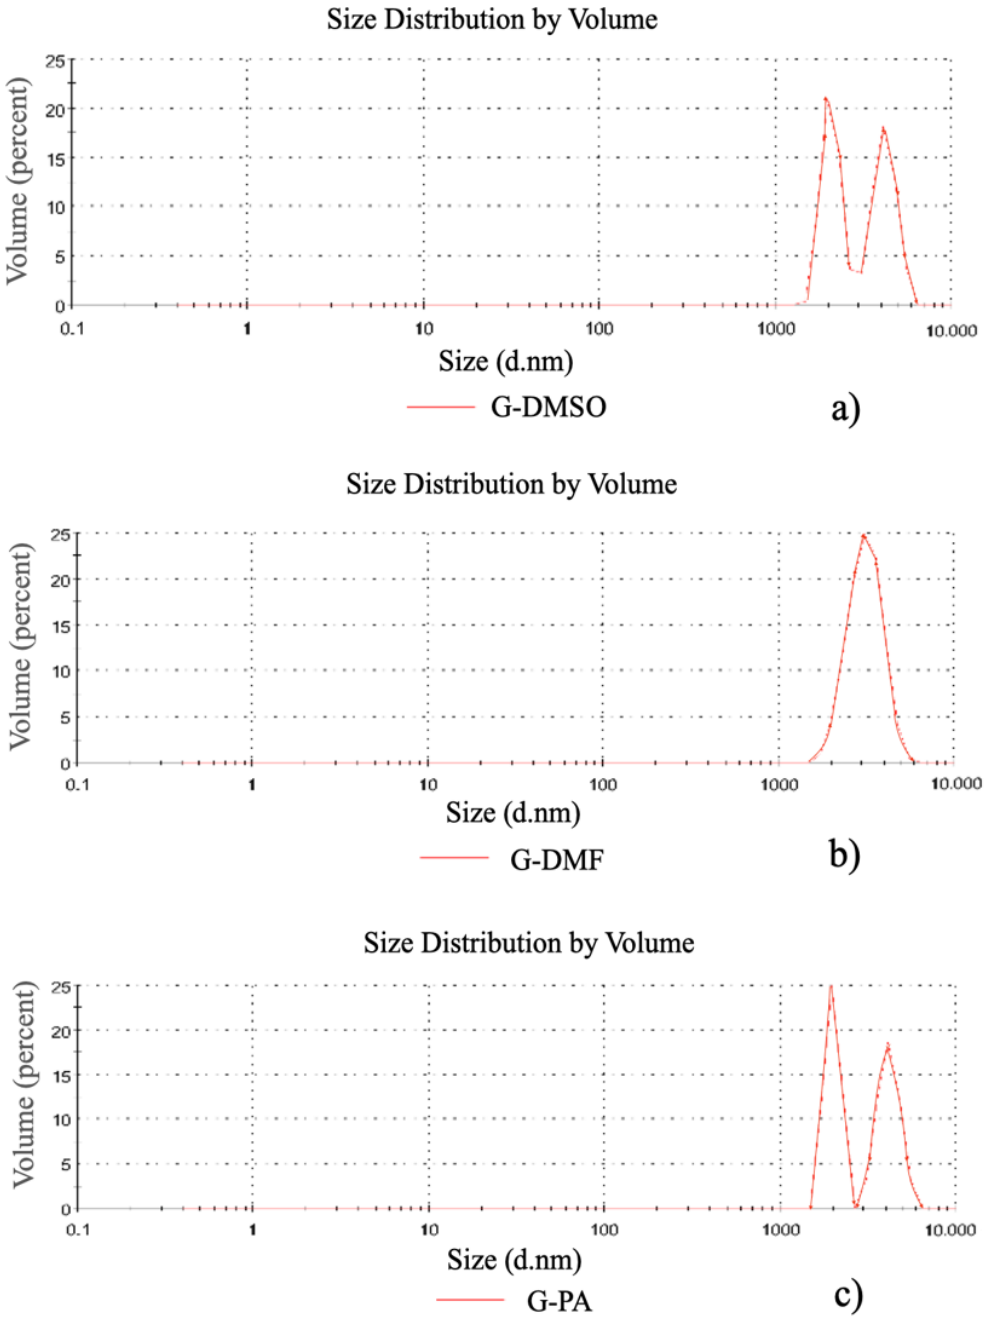
Figure 7. Particle size analysis results of synthesized samples, ( a ) G-DMSO, ( b ) G-DMF, ( c ) G-PA. TEM analysis revealed that G-DMSO and G-DMF have fewer layers while G-PA has multilayers.